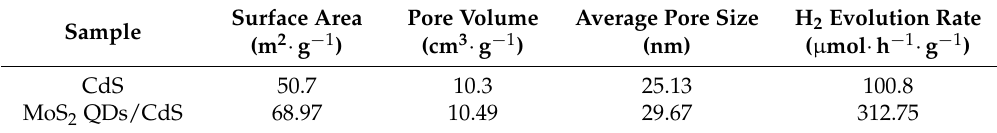
Table 1. The BET surface area, pore volume, average pore size and H 2 evolution rate of the samples.